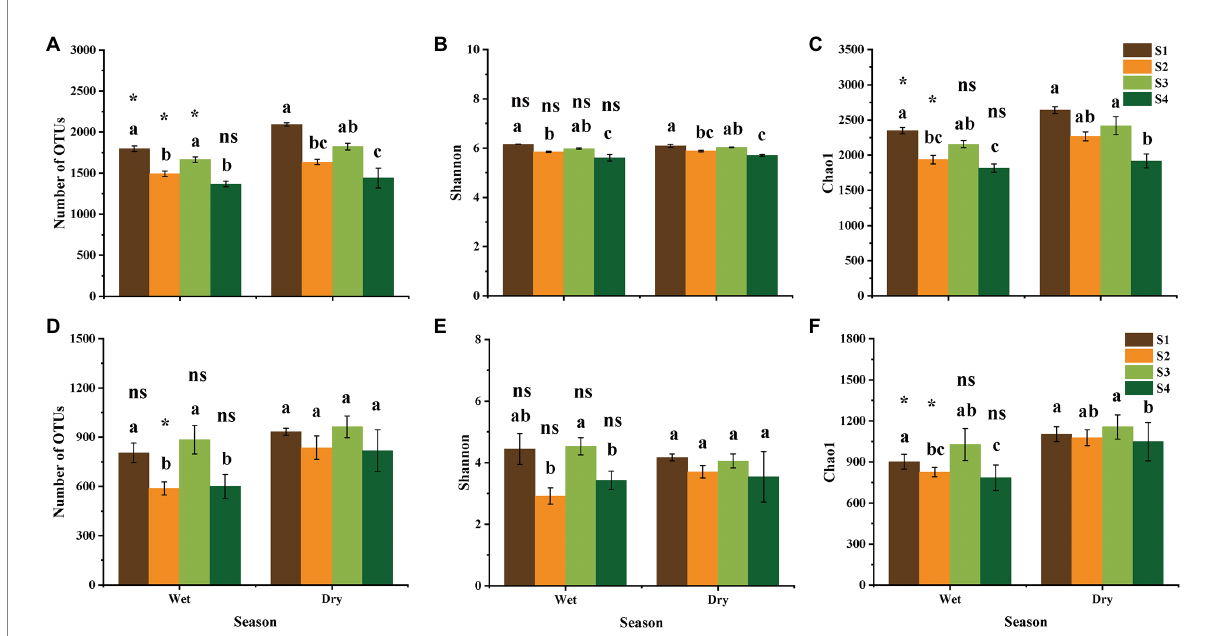
FIGURE 2 Observed number of OTUs, Shannon and Chao 1 indices of bacterial (A–C) and fungal (D–F) community in different stages of forest succession and seasons. (A,D) , observed number of OTUs; (B,E) , Shannon index; (C,F) , Chao 1 index. S1, S2, S3, and S4 represent the initial, early, middle, late stages of forest succession, respectively. Different lowercase letters indicate significant differences according to the Tukey’s HSD test at different forest successional stages in the same season ( p < 0.05). Symbols indicate significant differences according to the Student’s T test between different seasons at same successional stage. ns, not significant; *, p < 0.05.